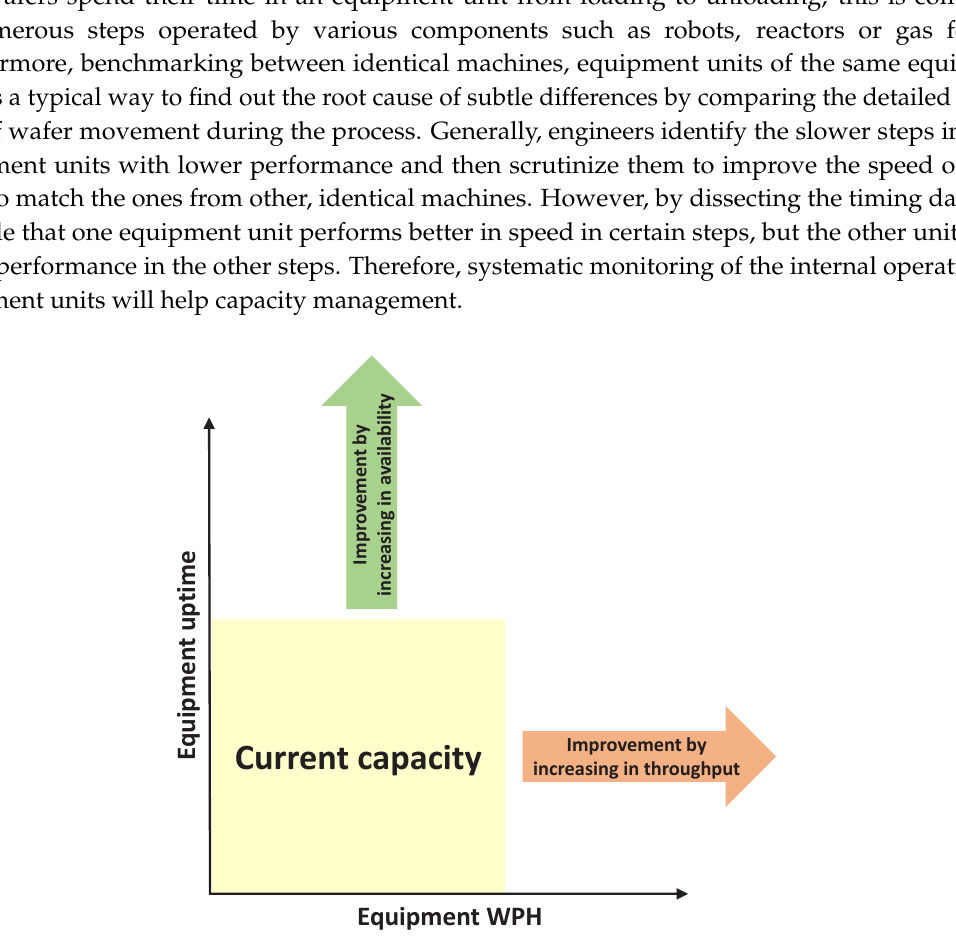
Figure 5. Illustration of capacity improvement. WPH, wafer per